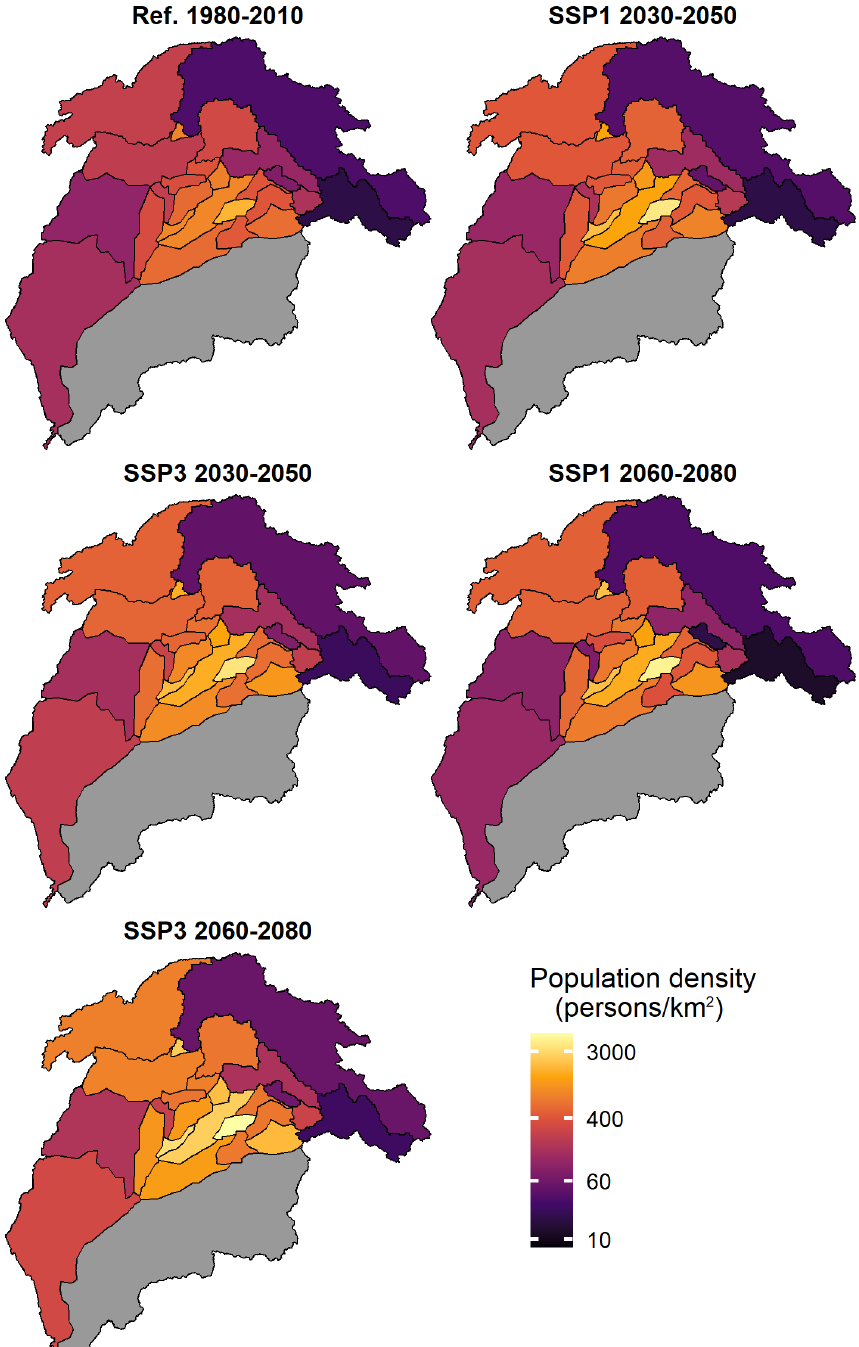
Figure A2. Population density of each upper and lower Indus sub-basin through time and for both scenarios, as used in this study. The population projections were sourced from Smolenaars et al. (2021, under review). They were developed by spatially downscaling the national population projections of the global SSP framework using a regionalized population model that considers urbanization, internal highland-to- lowland migration and proximity to infrastructure. These drivers were weighted relative to the scenario context sourced from both the global SSPs and pre-existing qualitative regional development storylines developed by Roy et al.